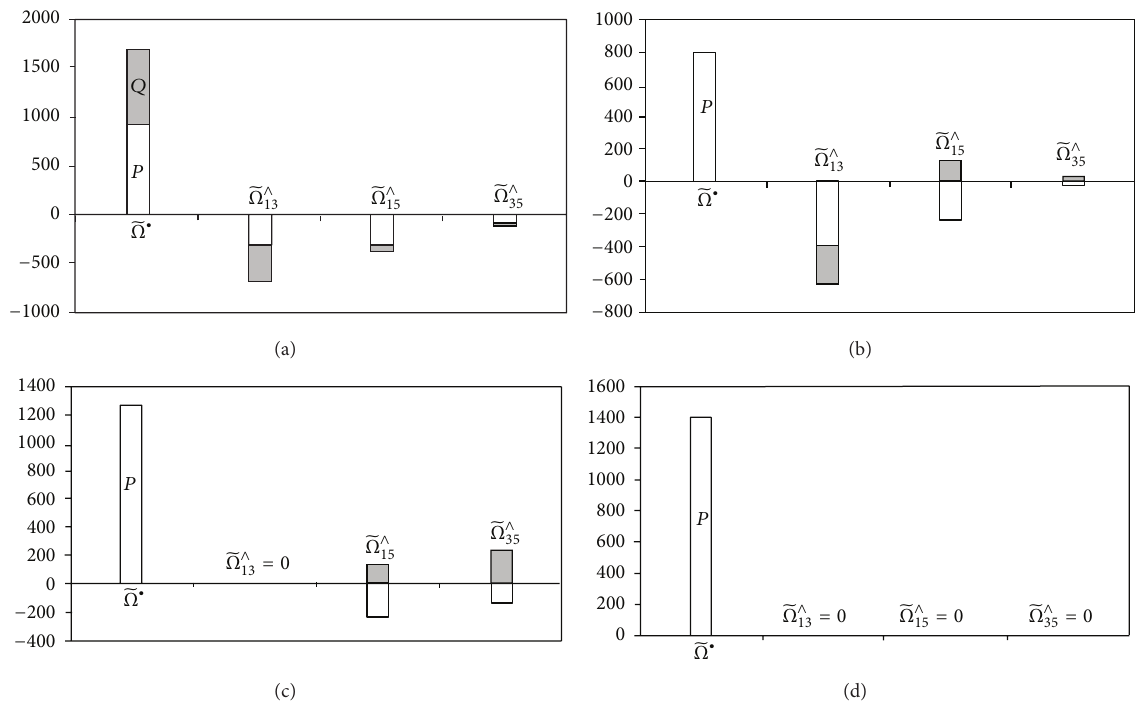
Figure 4: Apparent power components ( ◻ real part, ◼ imaginary part): (a) without compensation, (b) PPF compensation, (c) selective PAF- PPF compensation, and (d) total PAF-PPF